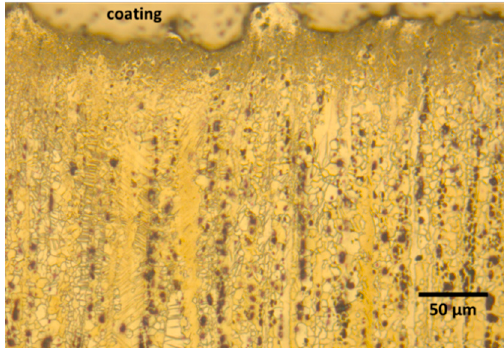
Figure 9. Optical micrograph of the interface ZE41-coating.